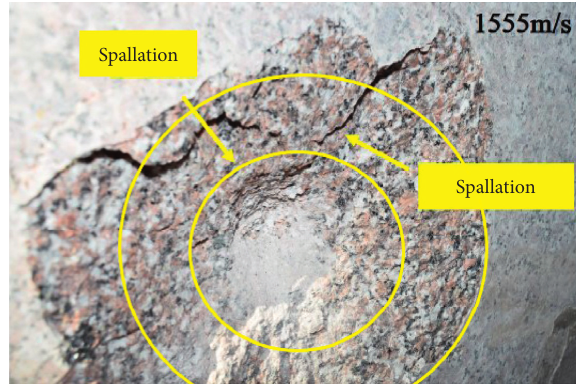
Figure 5: Spallation area around the center of the